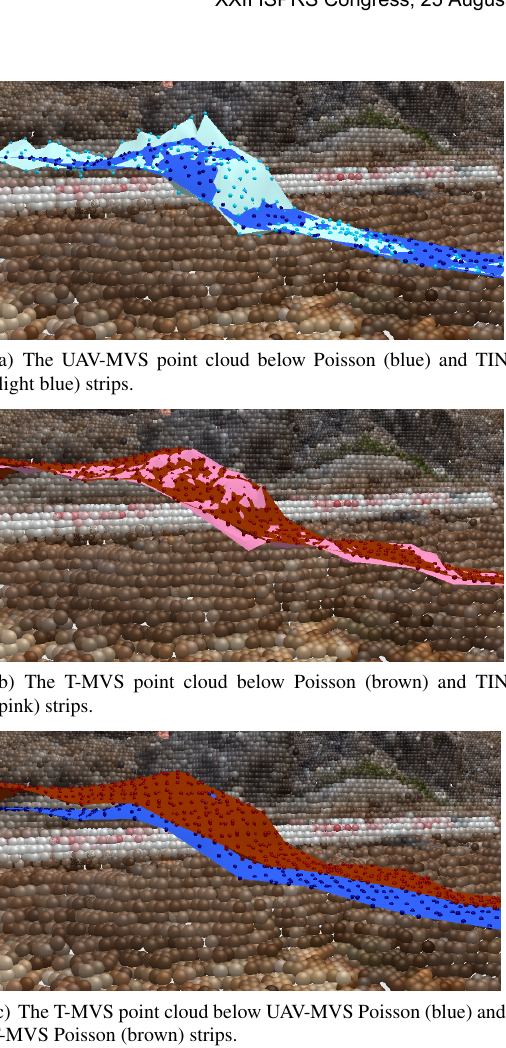
Figure 9: 6 cm wide strips of Poisson and TIN surfaces viewed over a pebbly beach section of the points clouds from which they were derived (Z-10 cm), each natural coloured dot has a 14mm